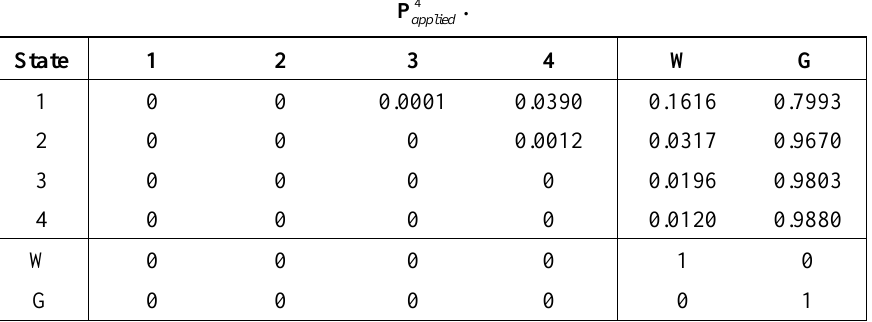
Table 18. The estimated transition probabilities matrix of applied sciences program